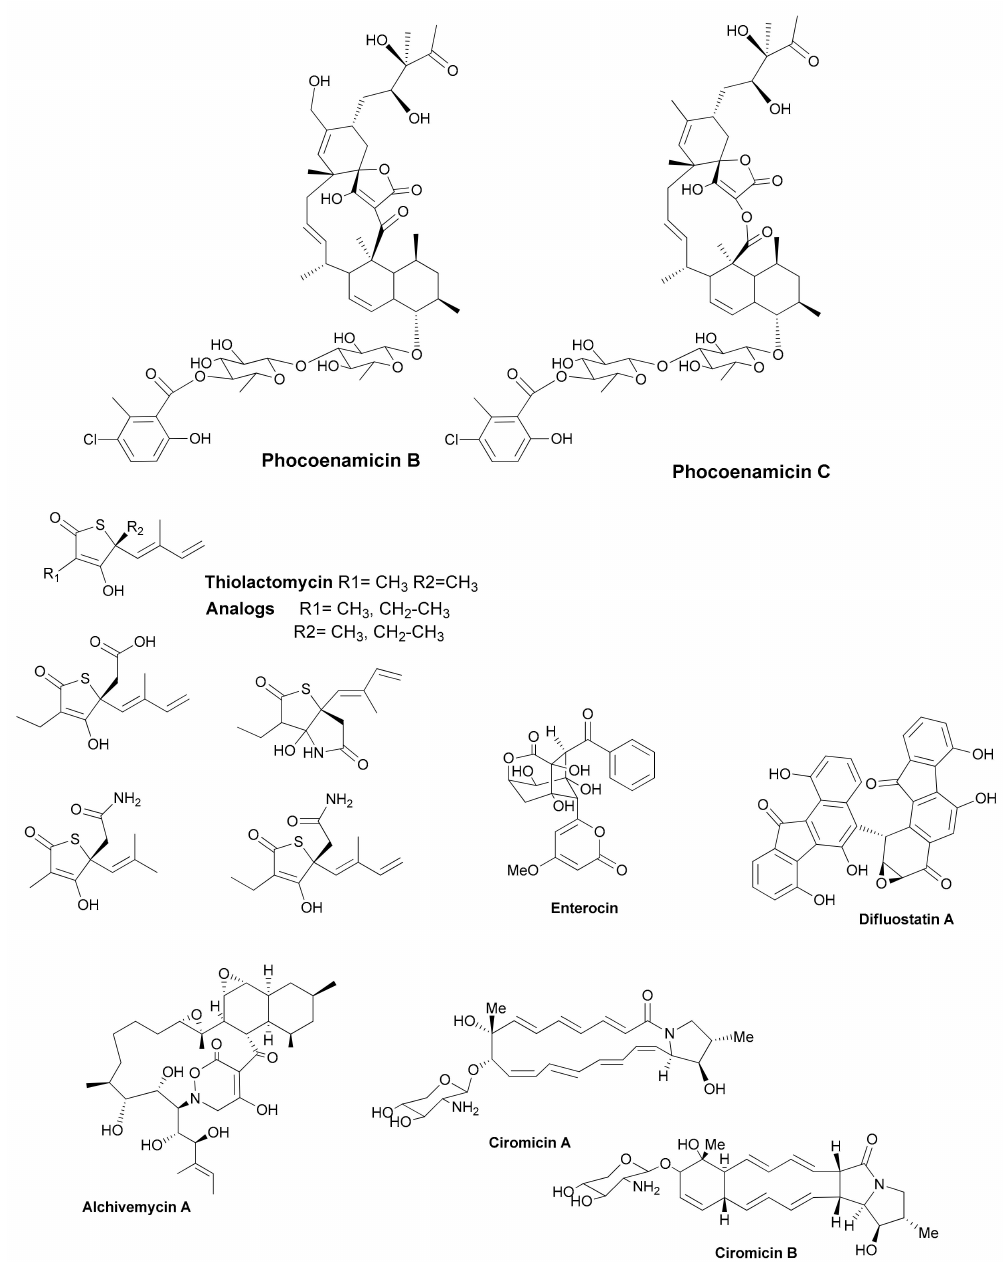
Figure 1. New antibiotics and analogs discovered from